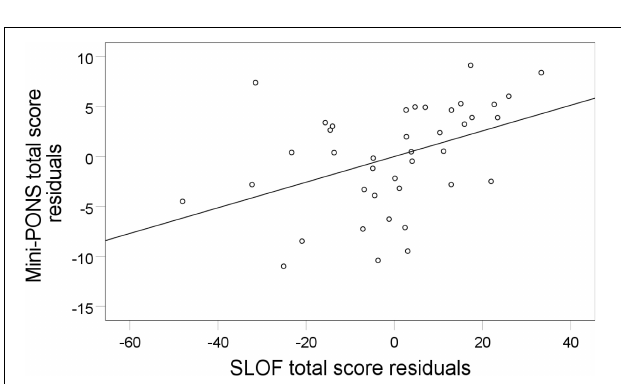
FIGURE 4 | Association between nonverbal social perception and functional capacity. Mini-PONS, mini profile of nonverbal sensitivity; UPSA-brief, University of California San Diego performance-based assessment. To plot the partial correlation between Mini- PONS total score and UPSA-brief whilst controlling for medication ( r = 0.42, p = 0.031), we used Mini-PONS total score residuals and UPSA-brief total score residuals.